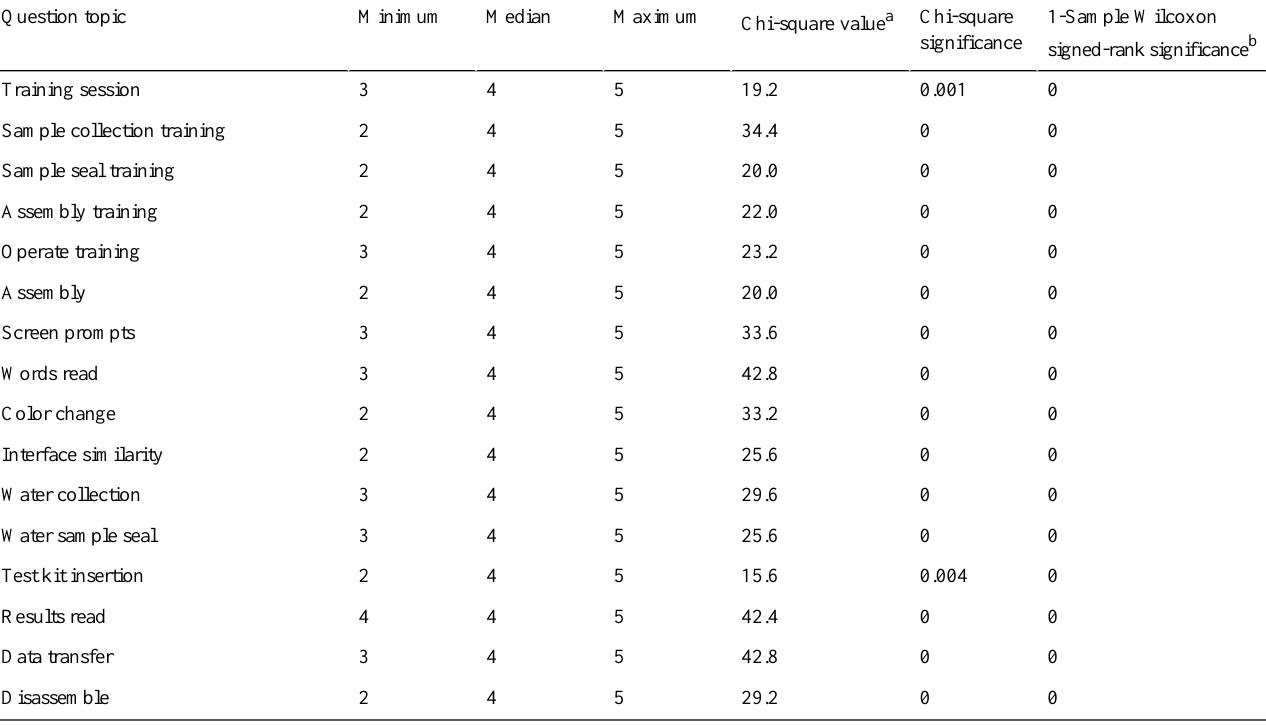
Table 4. Training evaluation and device usability chi-square goodness of fit and 1-sample Wilcoxon signed-rank tests.